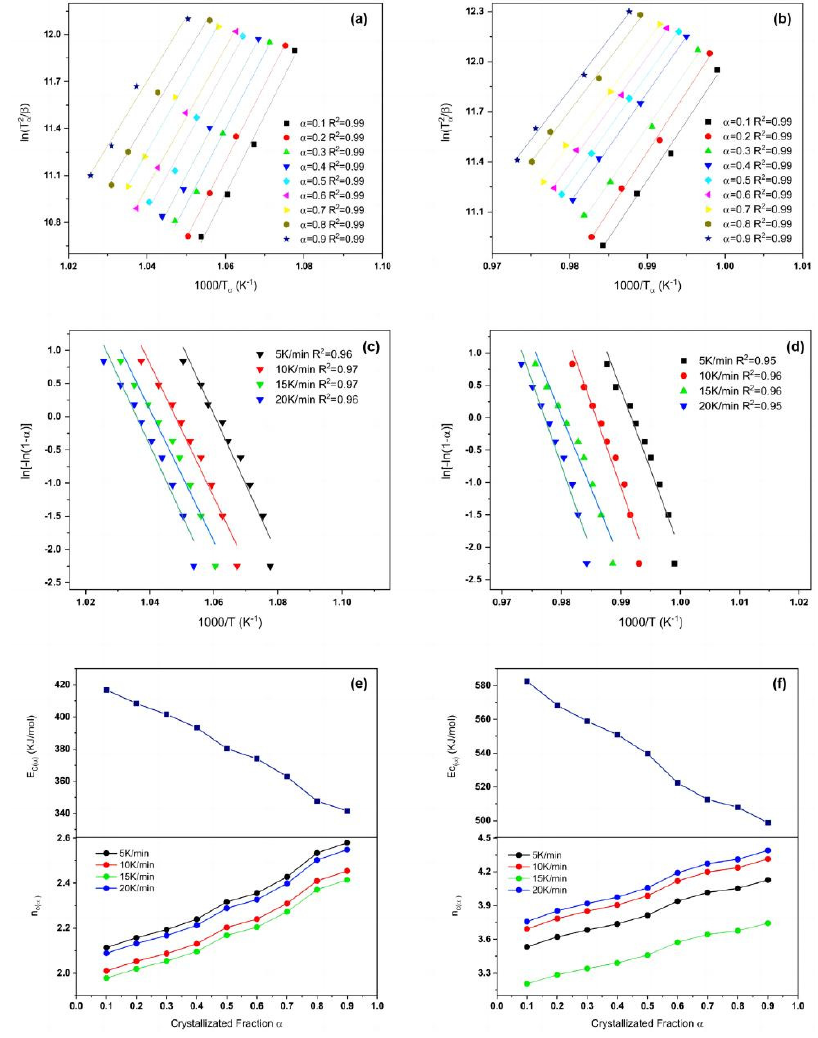
Figure 4. ( a , b ) Plots of ln( T α 2 / β ) vs. 1000/ T α for different integration numbers of the first and second crystallization peaks; ( c , d ) plots of ln[ − ln(1 − α )] vs. 1000/ T for different precipitation integration numbers of the first and second crystallization peaks; ( e , f ) E c ( α ) and n c ( α ) as a function of crystallized fraction α ; the error bars correspond to the standard errors from linear fitting.